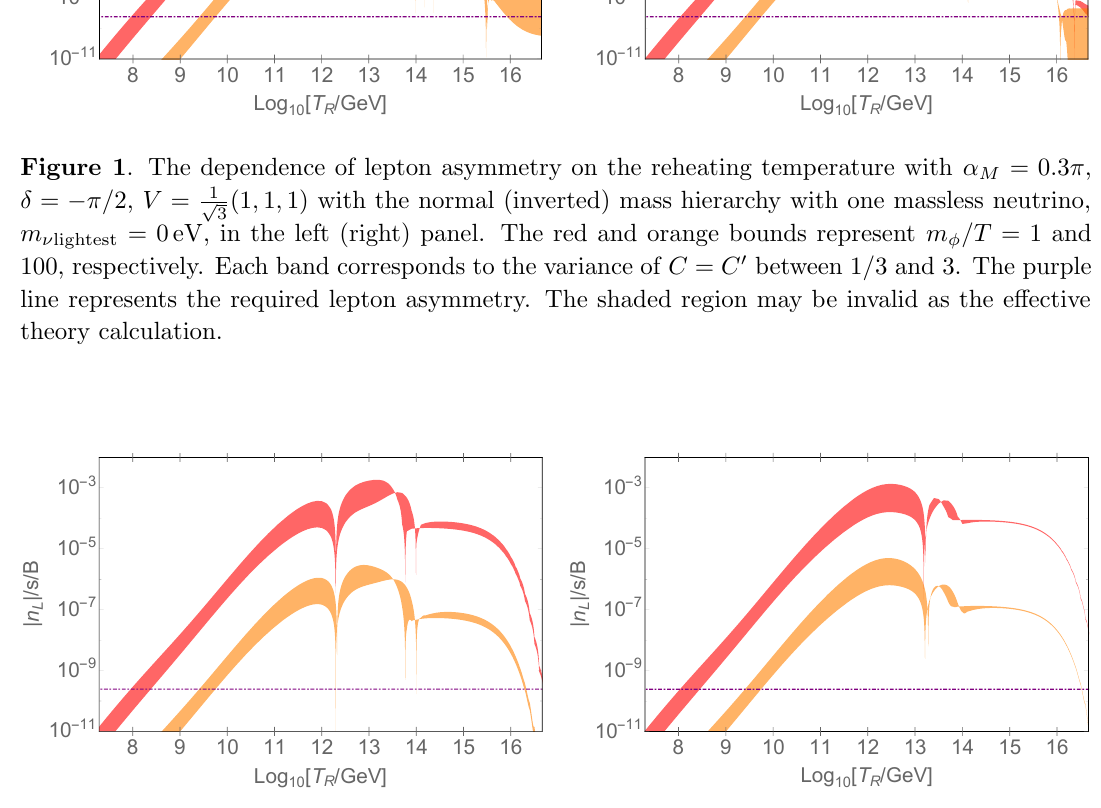
We show in (cid:12)gure 1 the absolute value of the lepton asymmetry by varying T while R (cid:12)xing the ratio m =T = 1 (red) or 100 (orange) with (cid:14) = (cid:0) (cid:25)= 2 ; (cid:11) = 0 : 3 (cid:25) . The vector R M (cid:30) V is set to be V / (1 ; 1 ; 1). The left and right panels, respectively, correspond to the normal and inverted hierarchies of neutrino masses. The lightest neutrino mass, m , (cid:23) lightest is set to be zero for both cases. The bands represent the uncertainties from the C and C 0 factors in eqs. (4.10), (4.11), and (4.12). We took C = C 0 and varied the value from 1 = 3 to neutrino mass is taken to be m = 0 : 07 eV, and (cid:11) = 0. We note that from the M 2 (cid:23) lightest p condition (3.4) by taking E . m T , which is the typical energy of scattering R (cid:30)